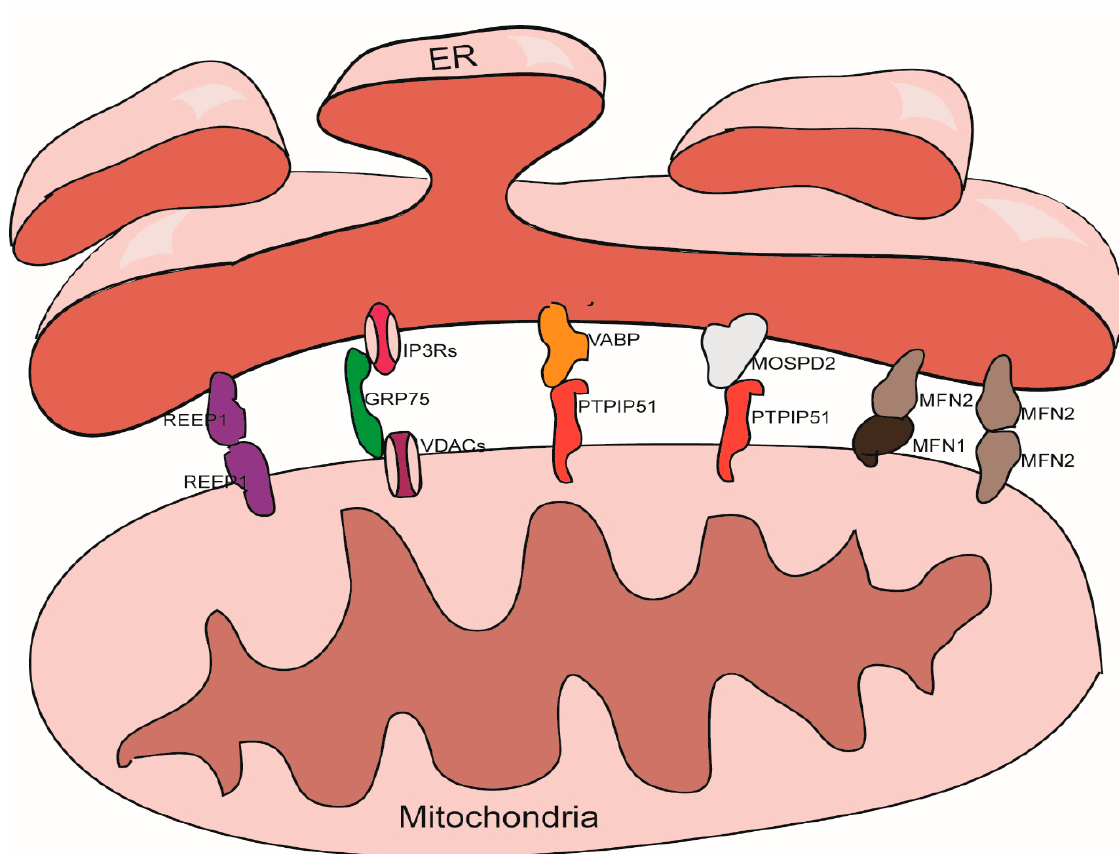
Figure 1. Tethering proteins that participate in the mitochondria-associated membranes (MAMs) structure maintenance.